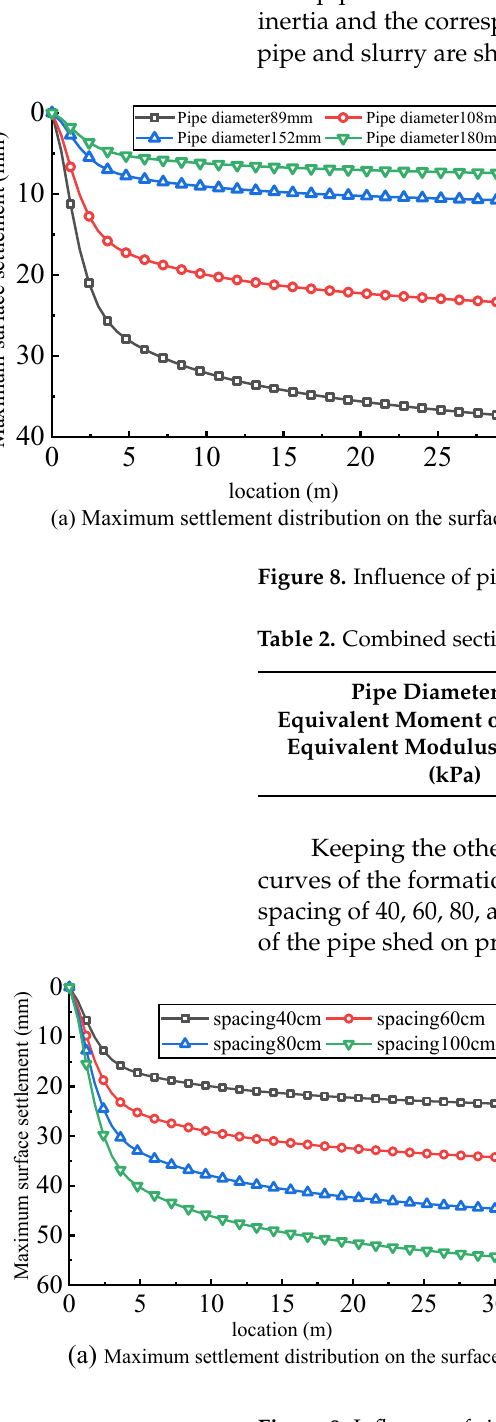
12 of 17 Figure 7. Distribution curve of the width of the surface settlement trough and maximum surface settlement.